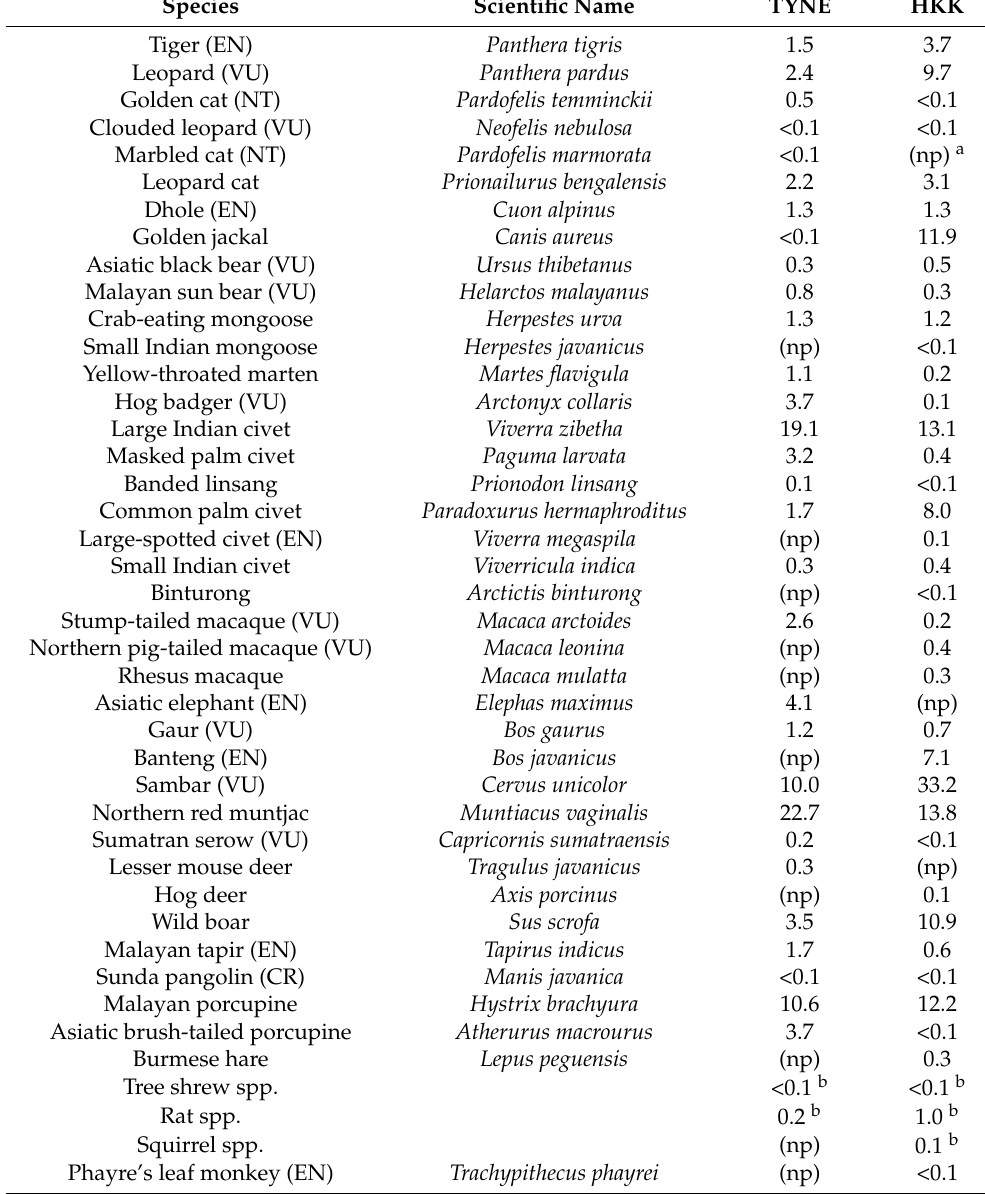
Table 1. A comparison of photographic rates (photos/100 trap nights) of mammal species recorded in Thung Yai Naresuan (East) (TYNE) Wildlife Sanctuary in April 2010–March 2012 ( n = 1817 trap-nights) and in Huai Kha Kheang (HKK) Wildlife Sanctuary in November 2017–March 2020 ( n = 6596 trap- nights; [21]) in Thailand. IUCN Red Book statuses (CR—Critically Endangered; EN—Endangered; VU—Vulnerable; NT—Near Threatened) are listed in